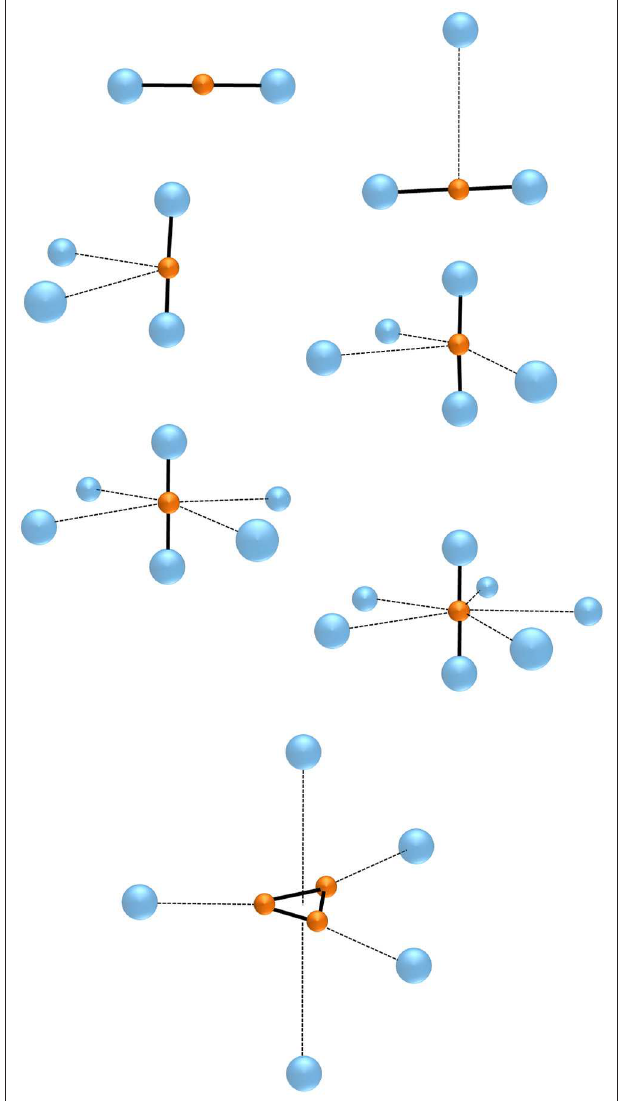
FIGURE 1 | Connectivities of the Ng-H-Ng + , (Ng-H-Ng + )(Ng) n ( n = 1–5), and H + 3 (Ng) 5